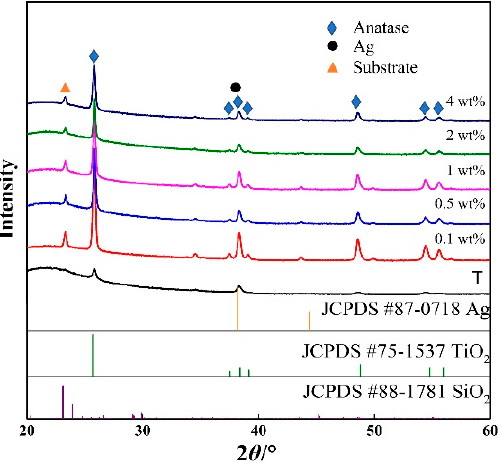
Figure 2. X-ray diffraction patterns of the pristine TiO 2 film and TiO 2 -Ag composite films deposited using different concentrations of AgNO 3 .